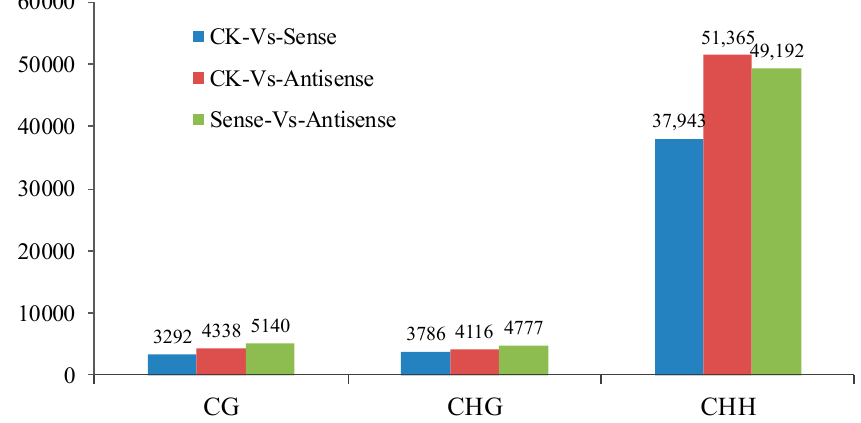
Figure 6. The differentially methylated regions (DMRs) of the different methylation types in different samples. Numerous DMRs were detected in the three comparative groups—3292, 4338, and 5140 DMRs were found in the CG methylation type; and 3786; 4116; and 4777 DMRs and 37,943; 51,365; and 49,192 DMRs were found in the CHG and CHH methylation types, respectively.